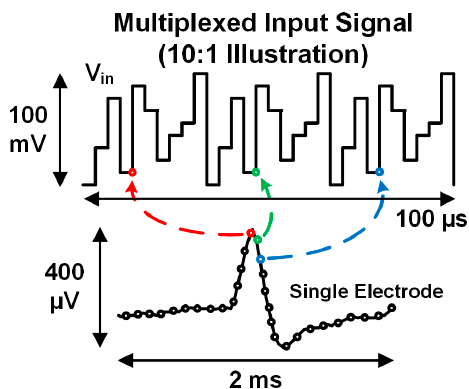
Figure 2. Illustration of the signal that arises from rapidly multiplexing multiple electrodes to the input of a single acquisition circuit. The amplitude of the signal is dominated by DC offsets from differences in polarization potentials between recording and reference electrodes. The goal is to acquire much smaller action potential signals, which are multiplexed in the time domain.